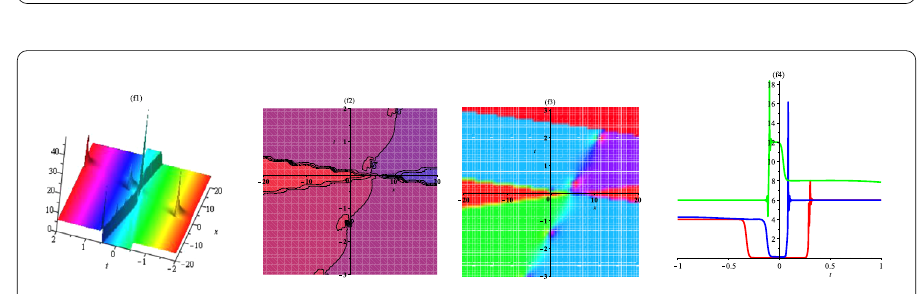
Figure 9 Diagram of 3-lump (2.20) by taking a = 1.5, b = 1, c = 2, d = 3, k 1 = 1, k 2 = 2, k 3 = 3, α = 0.1, (cid:14) = –1, τ = 2, η